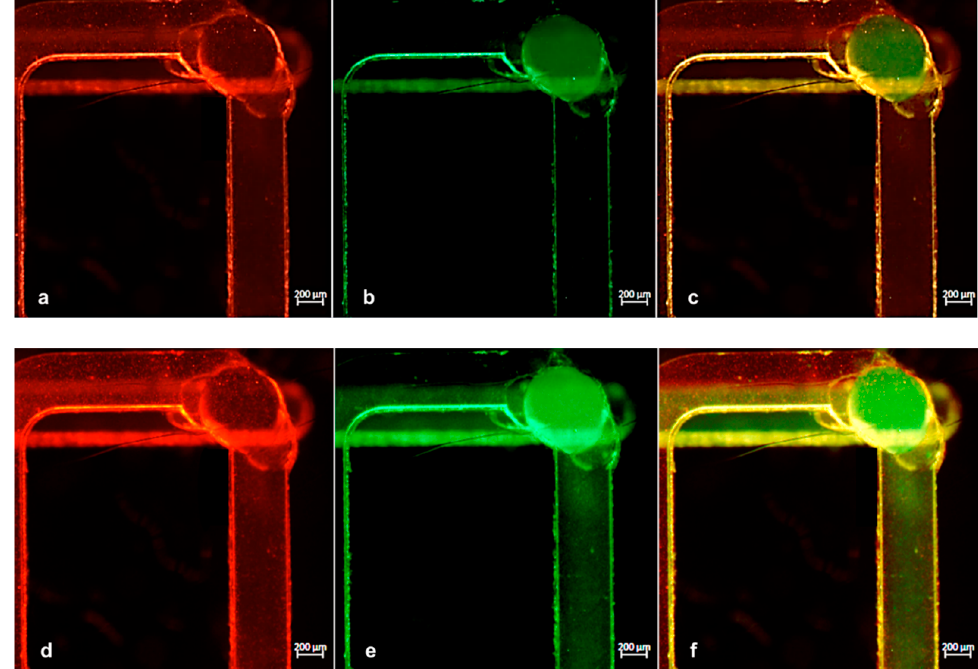
Figure 7. ( a , b ) Images of microchannels with green and red particles while running separately before reaching the interconnection point and ( d , e ) immediately after. ( c , f ) Merged images of green and red fluorescence acquisitions.